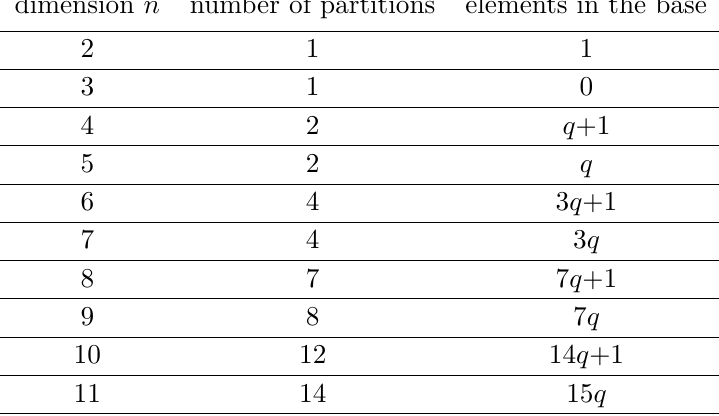
Table 1. Number of partitions and number of elements in the orthogonal Gram-Schmidt basis for a given dimension n